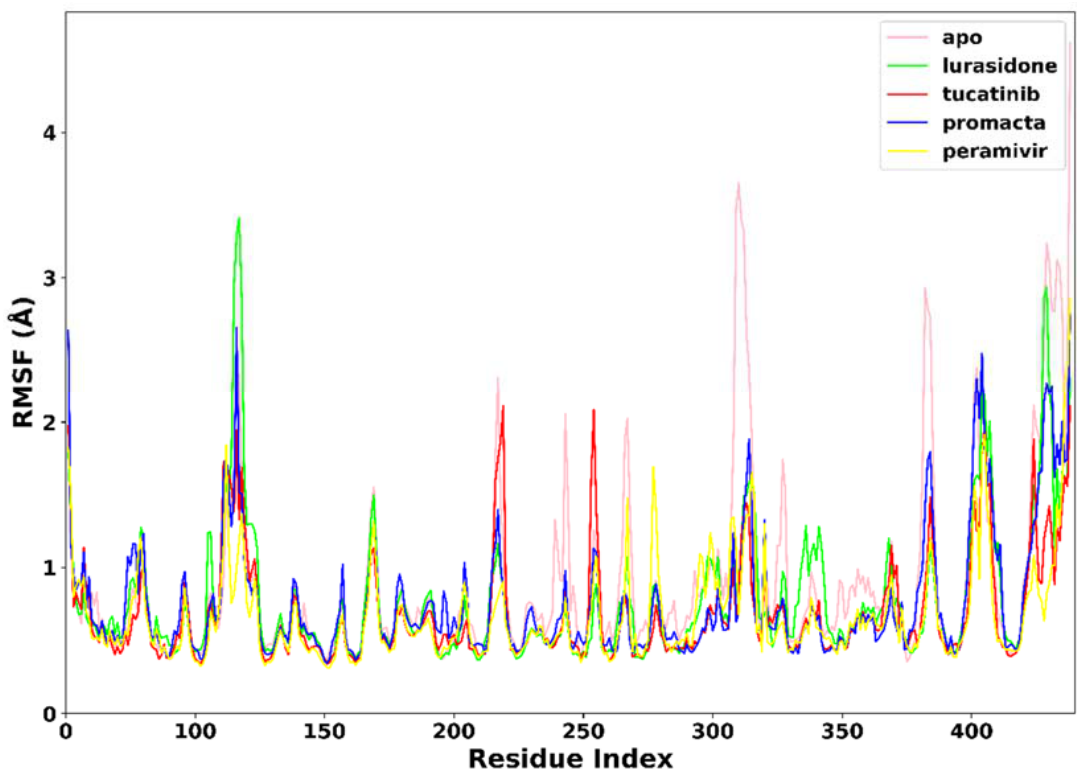
Figure 5. The RMSF trajectories of NA–ligand complexes during 250 ns simulations.